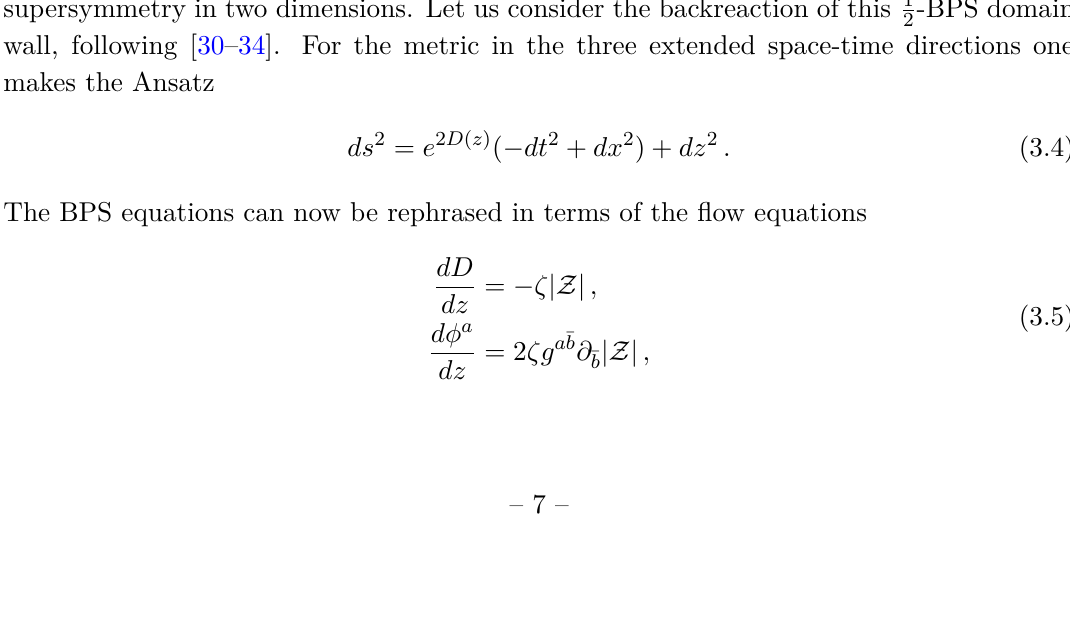
Figure 1 . The domain wall setup corresponding to an M5-brane wrapped on a Special Lagrangian 4-cycle dual to G 4 located at z = 0 and interpolating between a vacuum with G 4 = 0 and χ space-time filling M2-branes at z → −∞ and the supersymmetric AdS flux vacuum ( DW = 0 ) for G 4 6 = 0 at z → ∞ . For the case of supersymmetric AdS 4 vacua in type IIB orientifold flux compactifications the picture is similar with M2-branes replaced by D3-branes and the domain wall being made of D5/NS5